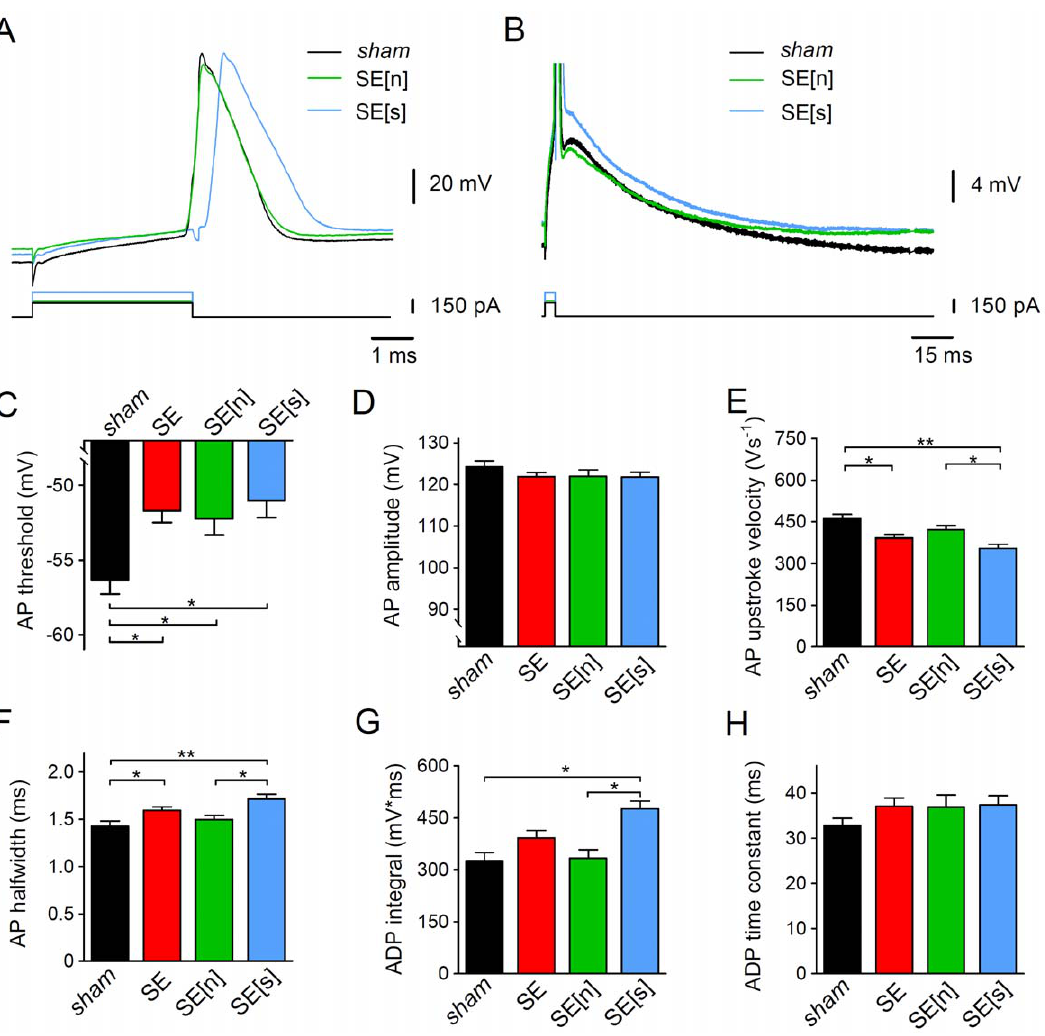
Figure 4. Properties of single somatic APs in CA1 pyramidal cells. A and B . Single somatic APs elicited by a just suprathreshold current injection of 4 ms duration (as indicated) in a sham cell (black traces) and different SE cells. SE cells were subdivided in SE[n] (notch present, green traces) and SE[s] cells (smooth, notch absent, blue traces). APs are shown on different time and voltage scales in A and B, respectively; panel A shows that in the SE cells the AP threshold was less negative, AP upstroke velocity smaller and AP halfwidth larger than in the sham cell (artefacts in the voltage traces coincide with the on- and offset of the current pulse but not with the AP peak. They were accounted for in the analysis, see Methods); panel B shows the presence (SE[n]) or absence (SE[s]) of the notch typically preceding after-depolarization (ADP) in sham cells. Compared to the sham cell, the area under the corresponding part of the voltage trace (ADP integral) was larger in the SE[s] cell. C . AP threshold for sham (black), SE (red), SE[n] (green) and SE[s] cells (blue); n=37, 61, 34 and 27, respectively; D . AP amplitude for sham , SE, SE[n] and SE[s] cells (n=37, 61, 34 and 27); E . AP upstroke velocity for sham , SE, SE[n] and SE[s] cells (n=37, 61, 34 and 27); F . AP halfwidth for sham , SE, SE[n] and SE[s] cells (n=37, 61, 34 and 27); G . ADP integral for sham , SE, SE[n] and SE[s] cells (n=28, 34, 20 and 14); H . ADP time constant (of decay) for sham , SE, SE[n] and SE[s] cells (n=28, 34, 20 and 14); * p , 0.05; ** p , 0.001 (ANOVA).